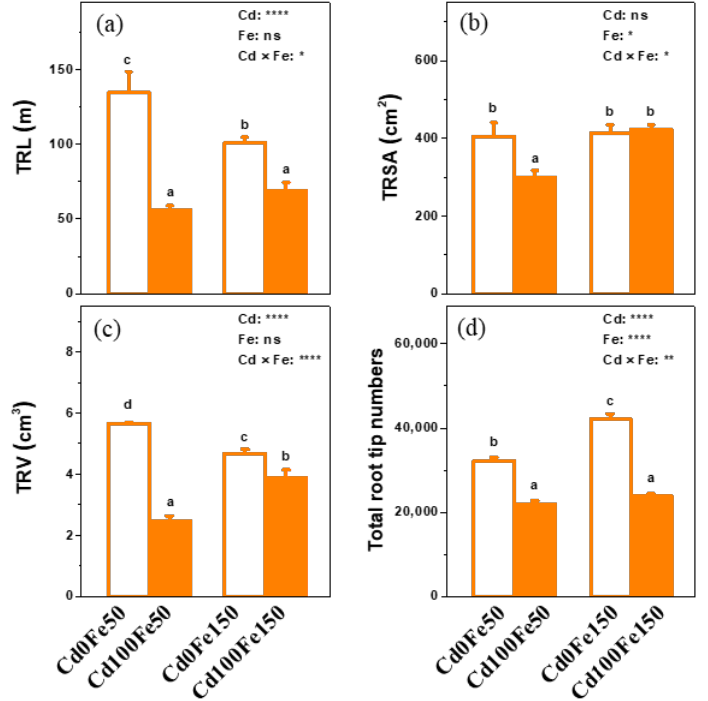
Figure 3. The TRL ( a ), TRSA ( b ), TRV ( c ) and total root tip number ( d ) of poplar under different Cd and Fe combined treatments. Data were means ± SE (n = 6). Different lowercase letters on the bars indicate significant differences in ANOVA ( p < 0.05). p values of two-way ANOVA on Cd, Fe, and their interaction (Cd × Fe) were indicated (*, p < 0.05; **, p < 0.01; ****, p < 0.0001; ns, not significant).